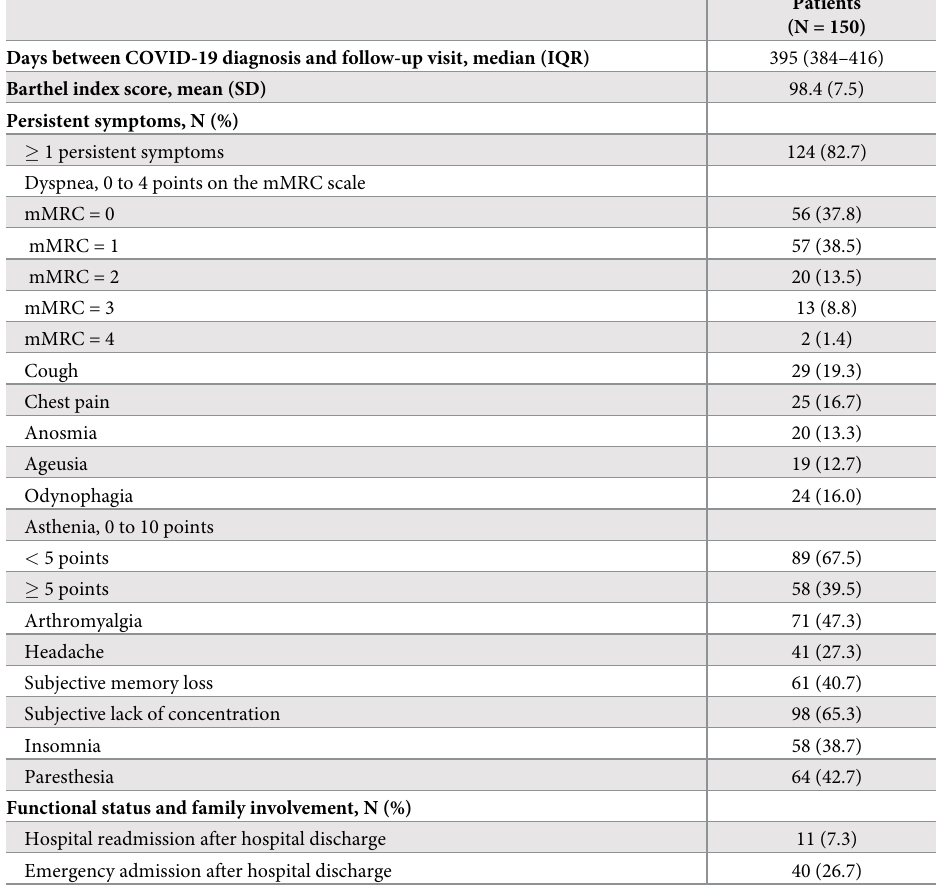
Table 2. Clinical characteristics and functional status at follow-up.